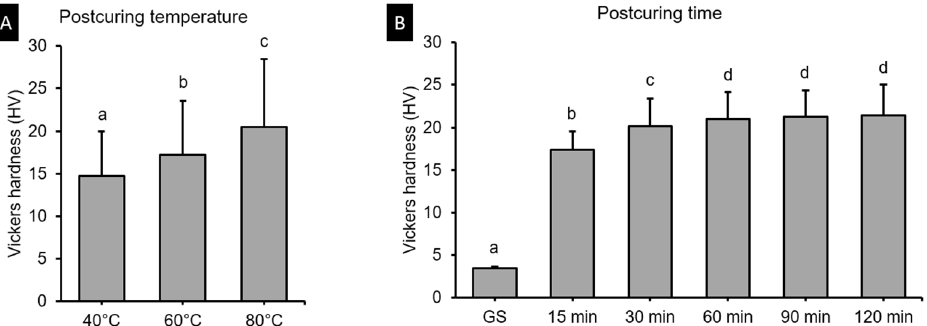
Figure 7. Results from two-way ANOVA. Vickers hardness data according to postcuring ( A ) temperature and ( B ) time. Data are mean and standard-deviation values. Different lowercase letters indicate a significant difference.